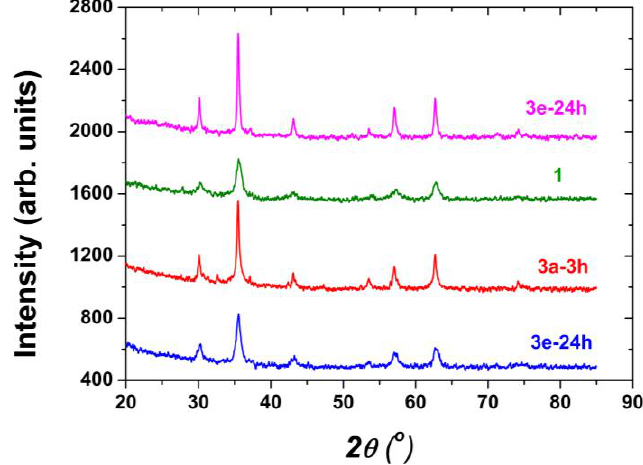
Figure 5. X-ray powder diffraction (XRPD) patterns of magnetic nanoparticles 3a -24 h, 3a -3 h, 1 and 3e -24 h.